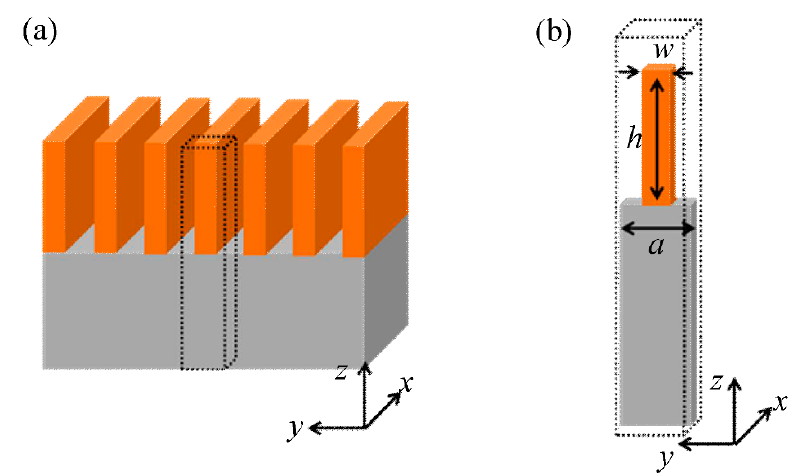
Figure 1. ( a ) Three-dimensional (3D) schematic representation of the one-dimensional (1D) periodic nanoridges phononic crystal ( b ) Elementary unit cell used for the finite infinite method (FEM) calculation where the lattice constant is a, the height of the nanoridge is h , and the width is w .